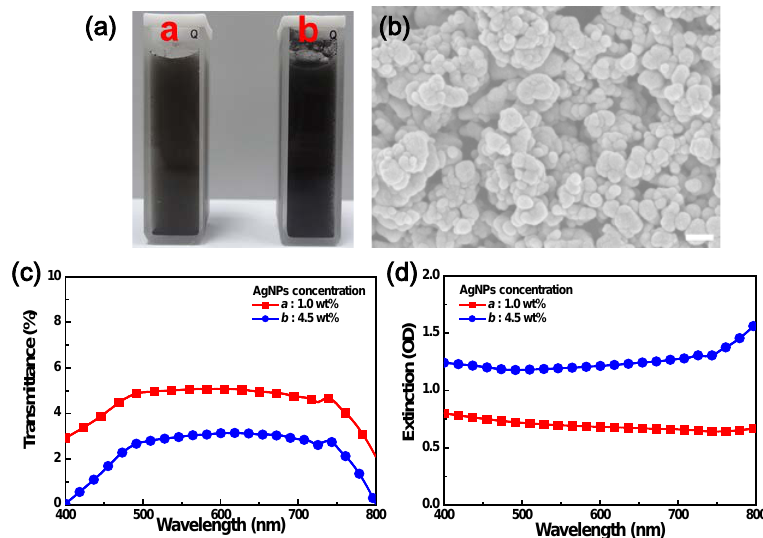
Figure 1. ( a ) Diluted solution appears black-brown because light is absorbed across the entire visible spectrum. ( b ) Field-emission scanning electron microscopy (FESEM) image of silver nanoparticle (AgNP) agglomerates at 4.5 wt % concentration. Inset scale bar is 200 nm. ( c ) Transmittance and ( d ) extinction spectra of AgNPs diluted solutions, which almost entirely to absorb all wavelengths